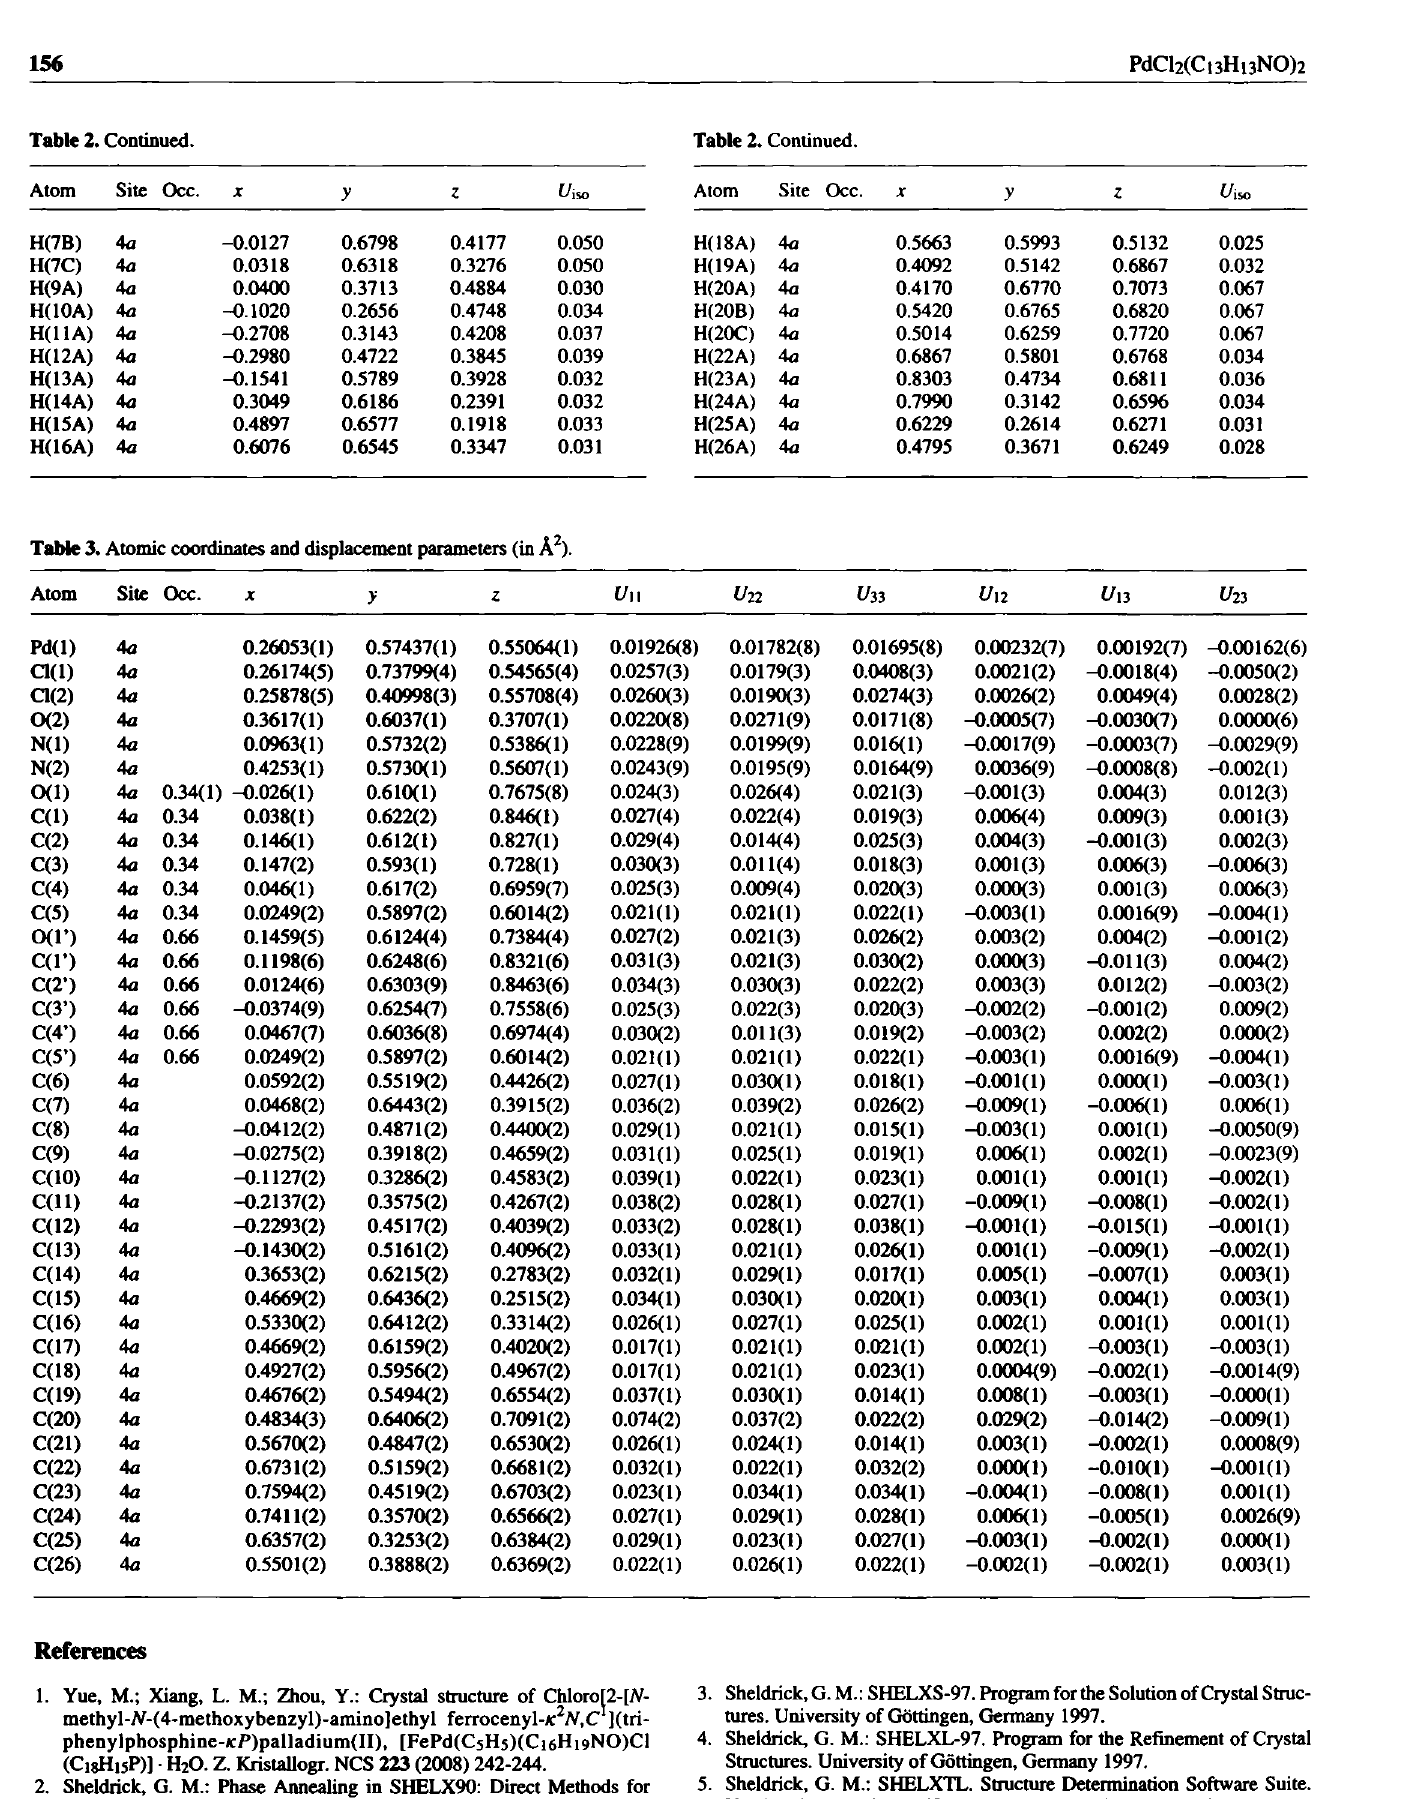
Table 3. Atomic cooidinates and displacement parameters (in Â 2